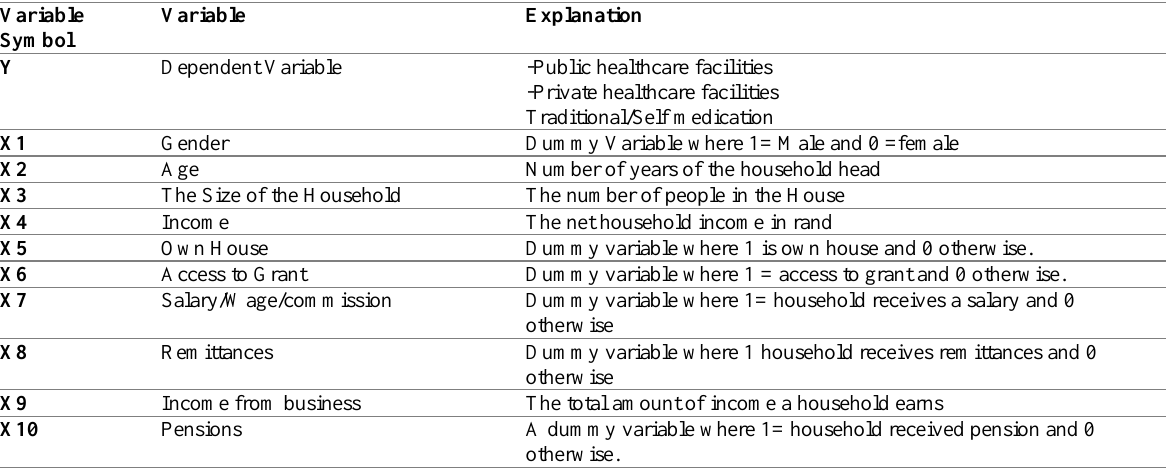
Table 1: Variables used in the Study